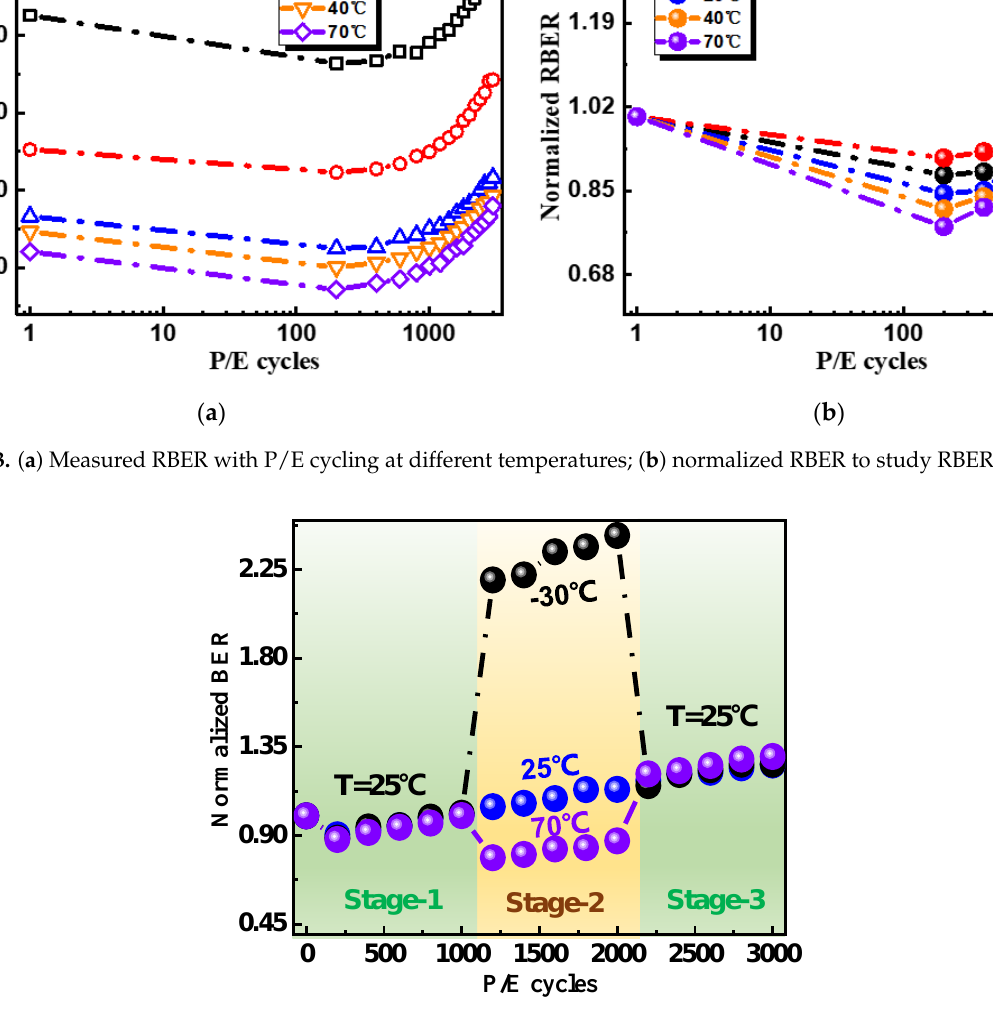
Figure 4. Cross-temperature characterizations to study degradation at various temperatures. The first and third stages were fixed to 25 °C, while the second stage selected three different temperatures, − 30, 25, and 70 °C. The RBER was normalized by the first point of the RBER to compare the degradation trends of each condition.